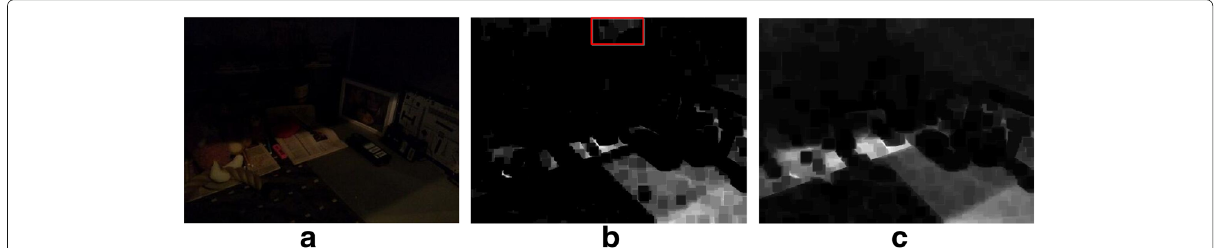
Fig. 3 An example of the dark channel and bright channel. a Input image. b Dark channel. c Bright